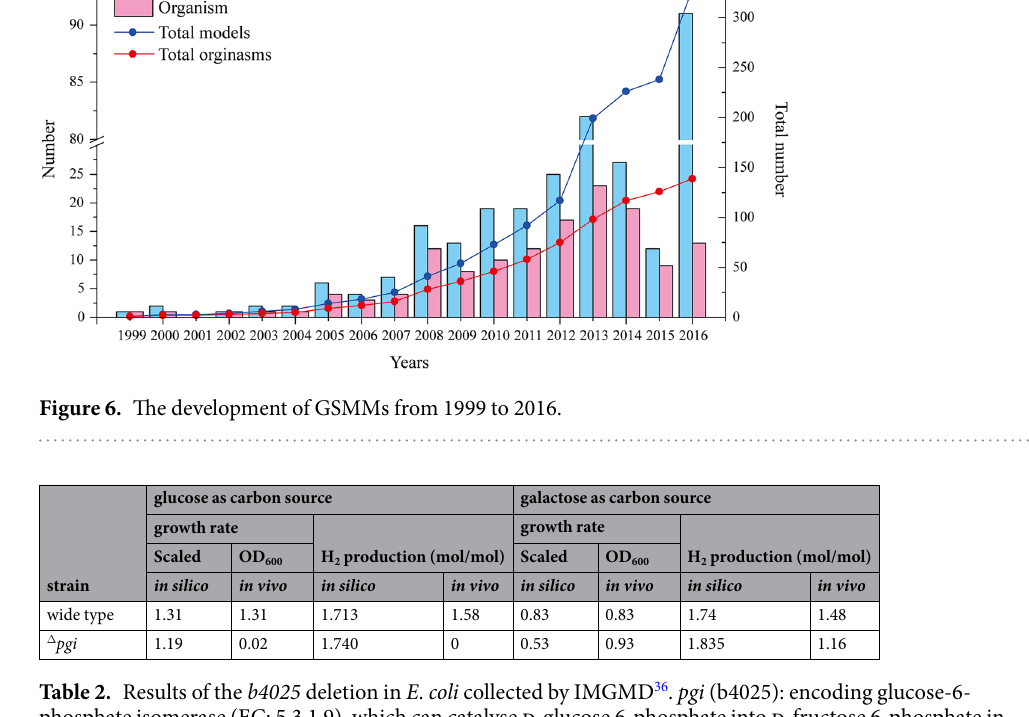
Table 2. Results of the b4025 deletion in E . coli collected by IMGMD 36 . pgi (b4025): encoding glucose-6- phosphate isomerase (EC: 5.3.1.9), which can catalyse d-glucose 6-phosphate into d-fructose 6-phosphate in glycolysis pathway.